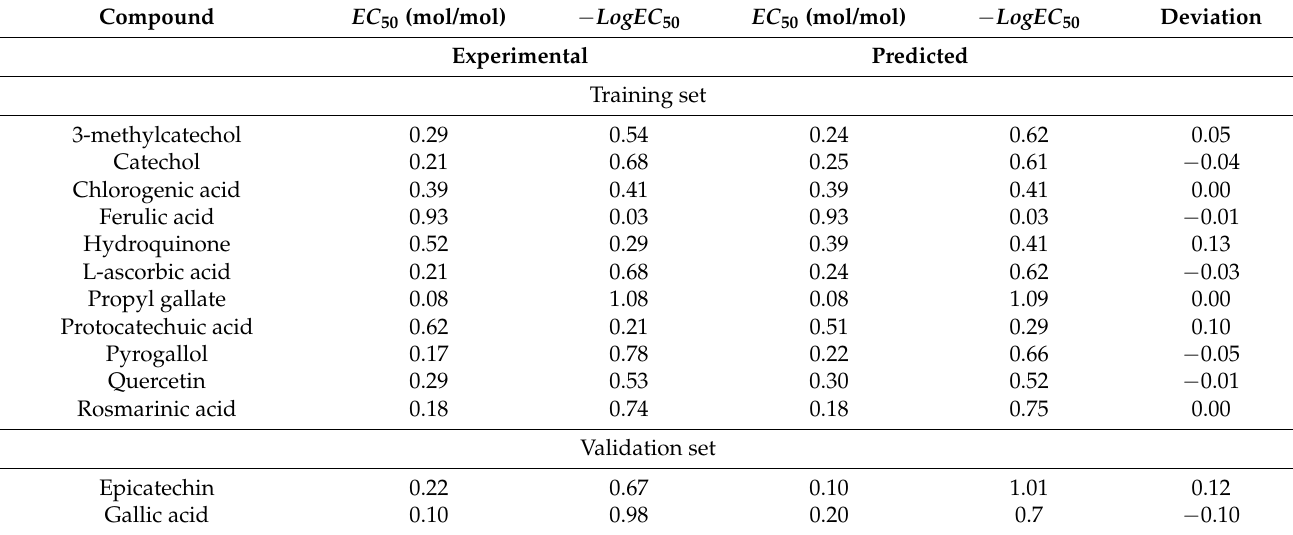
Table 5. Experimental and predicted values of EC 50 and their logarithms for each compound used in QSAR model with 10